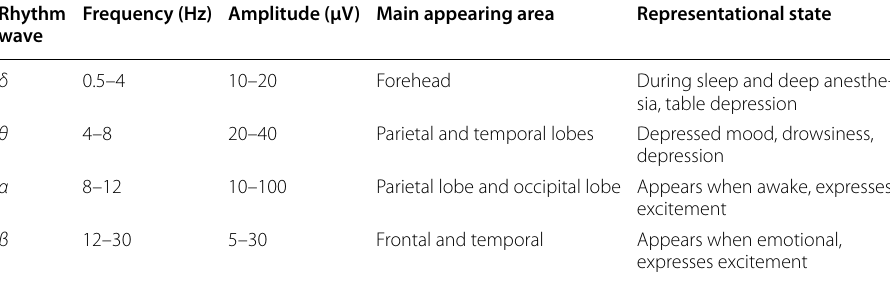
Table 1 Characteristics of each rhythm wave Rhythm